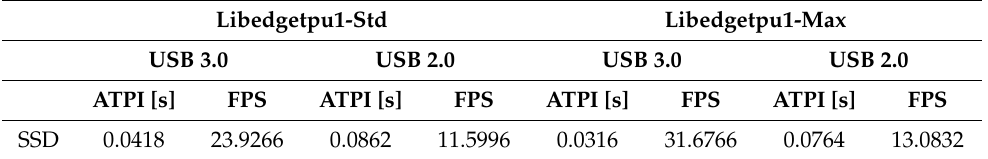
Table 4. Performance results for the Coral USB accelerator with two USB interface options and two performance settings. ATPI stands for average time per inference, and FPS is frames per